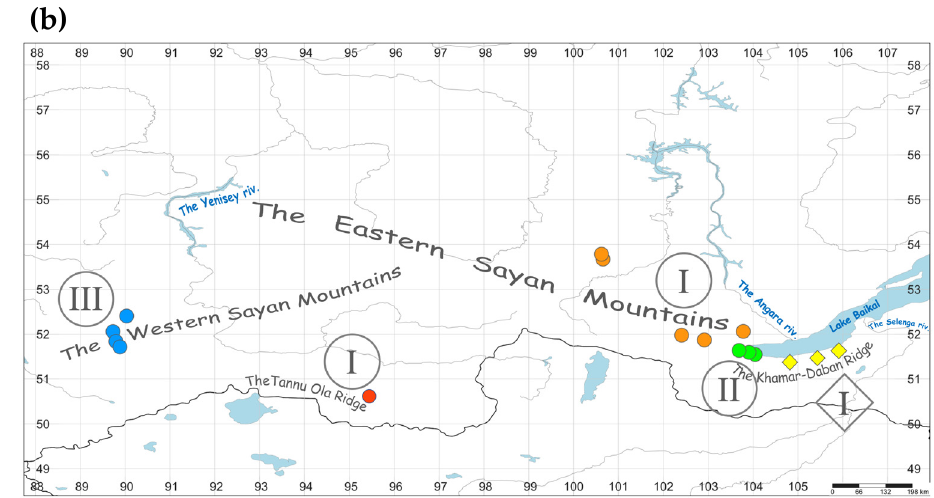
Figure 4. Phylogeny and phylogeographical patterns of Eranthis in South Siberia based on the com- bined ITS + ptDNA dataset. The color patterns and names correspond to those in Figure 1. Roman numerals indicate the main identified haplogroups/lineages. ( a ) BI phylogram. Posterior probabili- ties ≥ 0.95 are indicated above the branches, Bootstrap values for the corresponding clades on the ML tree (if relevant), below branches. The scale bar indicates the number of expected changes (sub- stitutions or/and indels and inversions) per site corresponding to a unit of branch length. *—branch position was inferred using the combined dataset of ITS and only trnL + trnL-trnF for ptDNA; **— branch positions were inferred from the independent analysis using ptDNA alignment with com- pletely deleted multiple indel regions and not including the binary matrix (see Section 2.4). Kh1–